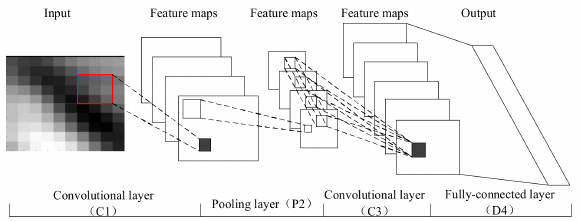
Figure 3. Structure of a typical convolutional neural network